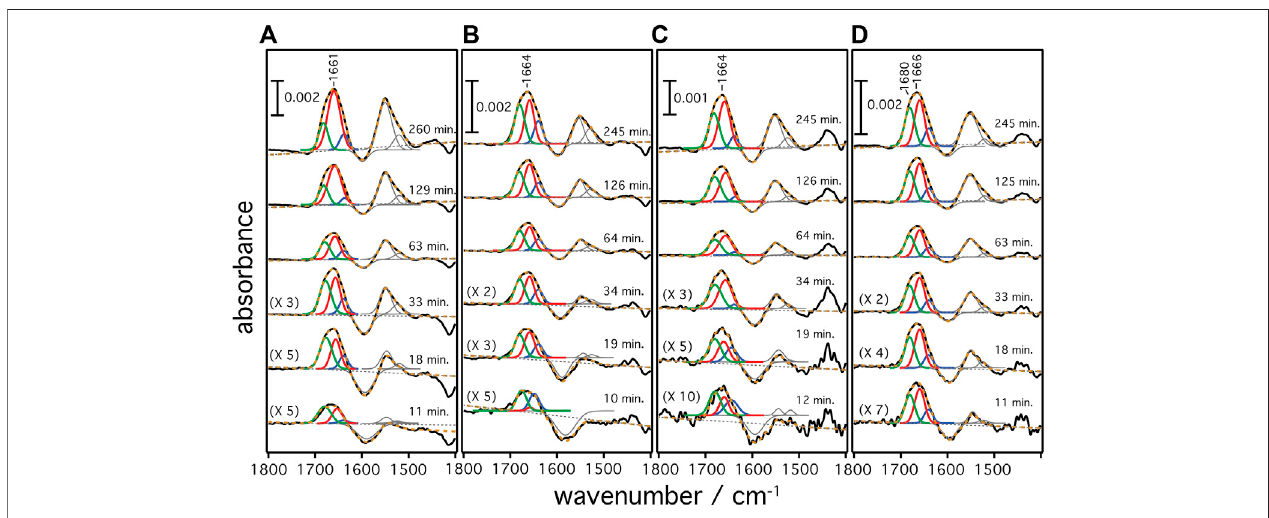
FIGURE3| Secondarystructurecontributionsovertimeduringthecell-freeexpressionof (A) Hs BR, (B) Cr ChR2, (C) Hs SRI,and (D) Hs SRIIaregiven.RawSEIRA spectra are shown as black solid curves. The dashed orange curves are the cumulative fi t of the individual components. Colored fi ttings represent the contribution from bend/misfolded (green), α -helices (red), and random (blue) components, respectively.